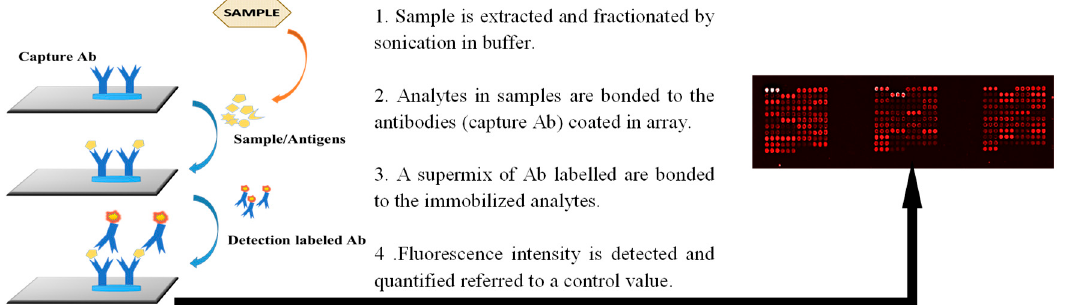
Figure 1. The scheme of the sandwich immunoreaction occurring in each spot printed in the microarray with the main steps of the procedure. The image on the right is an example of one of the nine arrays in the slide. Red spots (printed in triplicates) indicate the recognition of epitopes in the sample between the antibodies fixed in the slide and labelled antibodies in the supermix.